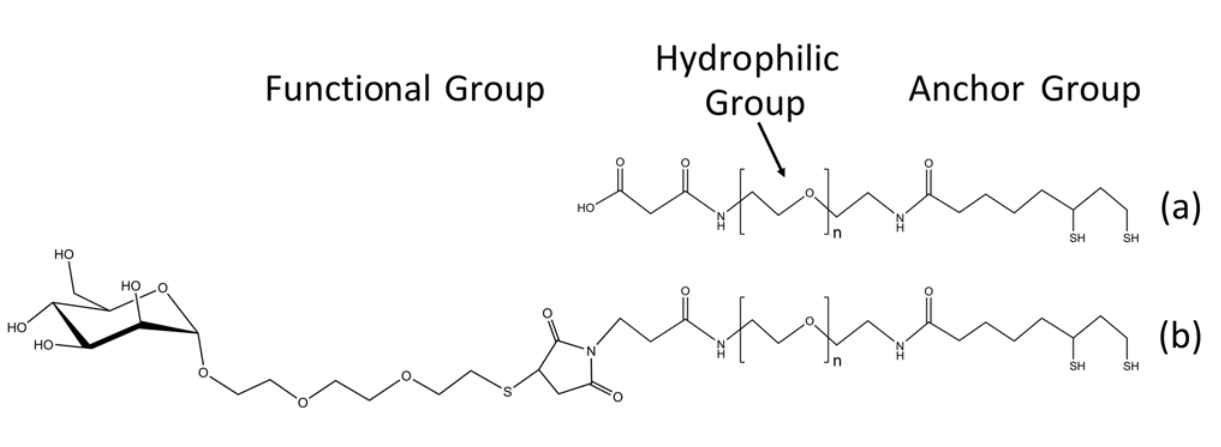
Figure 5. Water soluble functional ligands for biological applications consisting of a bidentate linkage group that connects to the quantum dot surface, a poly(ethylene glycol) chain for solubility, and a functional end group consisting of (a) a carboxylate group [96,99] or (b) D -mannose